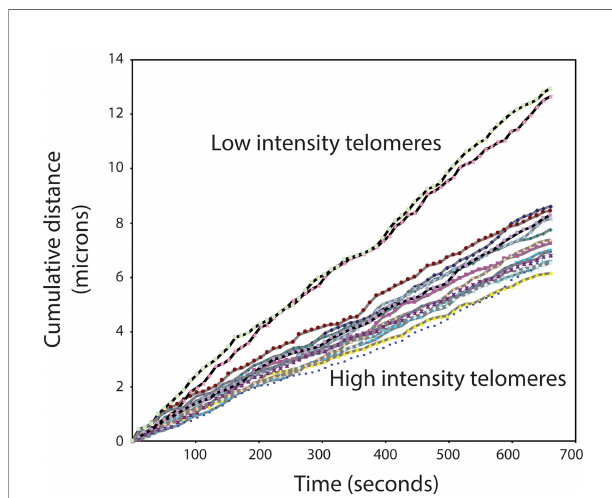
FIGURE 3 | High mobility of very short telomeres in cultured mouse embryonic stem cells. Viable cells, tagged with Venus-TRF1, were imaged at a fi xed position over 10 minutes. The position of individual fl uorescent telomere spots was recorded every 10 seconds. Two categories of telomere spots were observed: low intensity spots and high intensity spots. The recorded position of each spot at each time interval was used to calculate the travel distance of individual telomeres. See Supplementary Information and Supplementary Movie 3 for